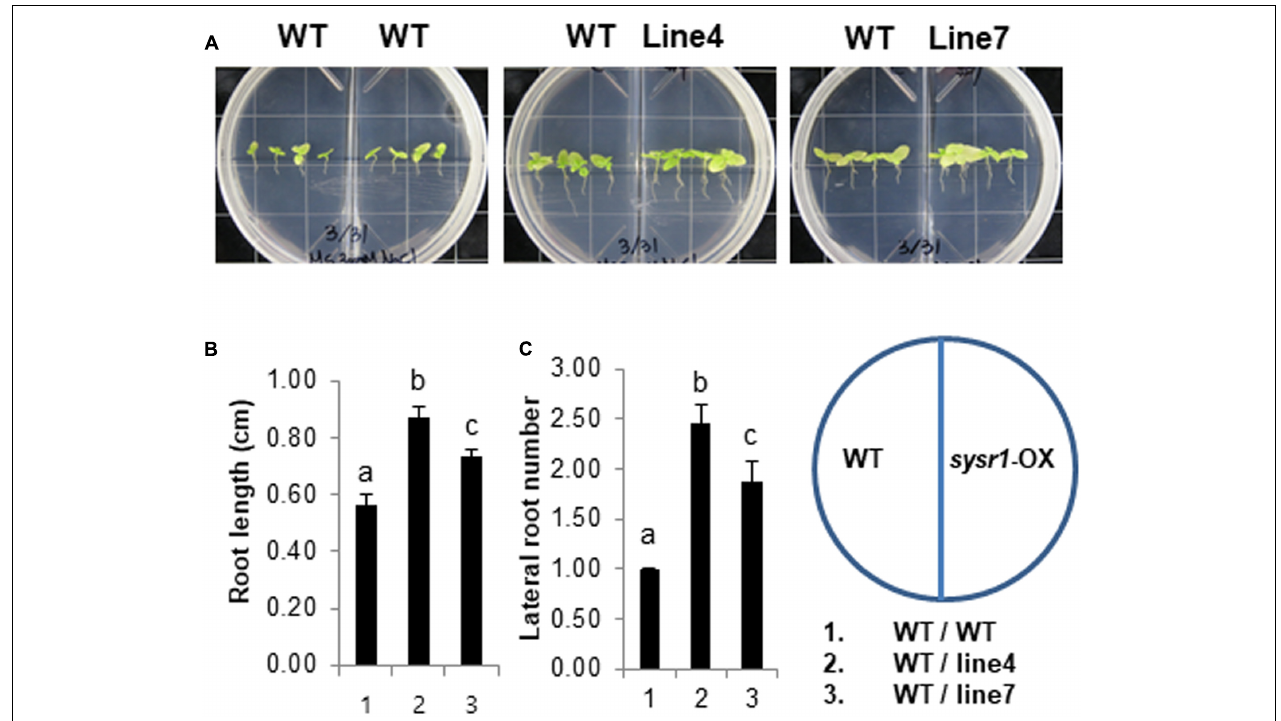
FIGURE 6 | Effects of VOCs emitted from salt-stressed sysr1 -OX plants on the salt tolerance of neighboring WT plants. (A–C) Two-week-old WT and transgenic plants (Lines 4 and 7) grown on Murashige and Skoog agar medium were transferred to the same medium containing 300 mM NaCl, and plants were allowed to grow for an additional 4 weeks. We used two-compartment plates with WT seedlings in one compartment and sysr1 -OX or WT seedlings in the other. (A) Phenotypes of WT and transgenic plants grown on Murashige and Skoog agar medium supplemented with 300 mM NaCl. (B) Root length analysis of WT plants grown with sysr1 -OX plants. (C) Analysis of lateral root numbers in WT plants grown with sysr1 -OX plants. All values are mean ± SD of three independent experiments ( n = 8 seedlings per experiment). Different letters represent significant differences at P < 0.05 ( t -test). Bars indicate the standard deviation of the